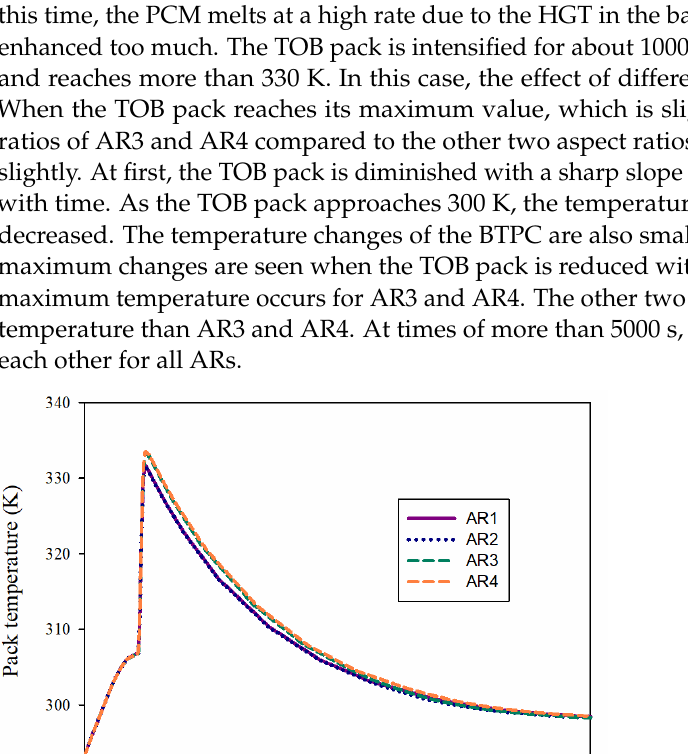
Figure 9. TOB pack for different values of cavity AR up to 6000 s.